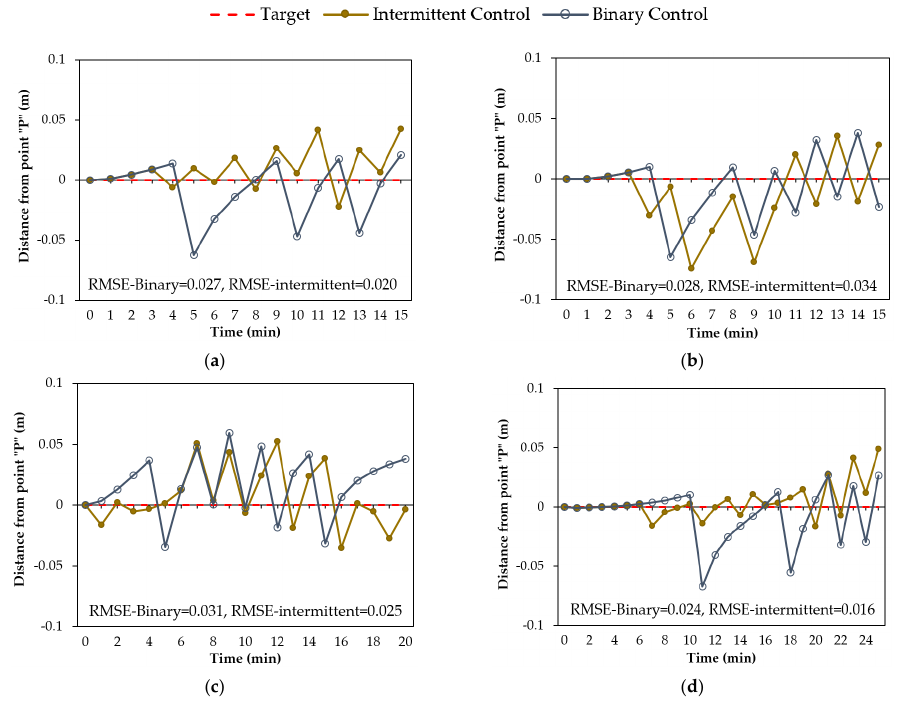
Figure 11. DRL-controlled groundwater using action space sizes of two (binary) and five (intermit- Figure 11. DRL‑controlled groundwater using action space sizes of two (binary) and five (inter‑ tent) during rainfall events: ( a ) 15-min-constant; ( b ) 15-min-normal; ( c ) 20-min-descending; ( d ) 25- mittent) during rainfall events: ( a ) 15‑min‑constant; ( b ) 15‑min‑normal; ( c ) 20‑min‑descending; min-ascending. ( d )